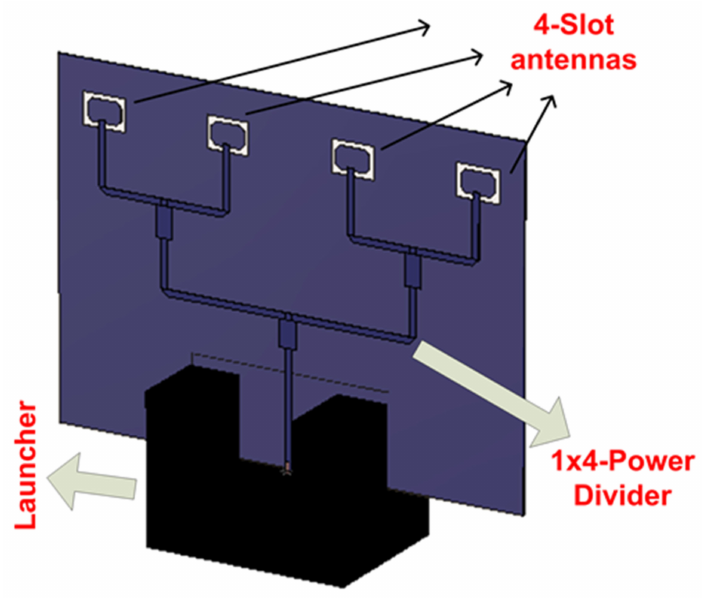
Figure 6. The geometry of the 1 × 4 antenna array.